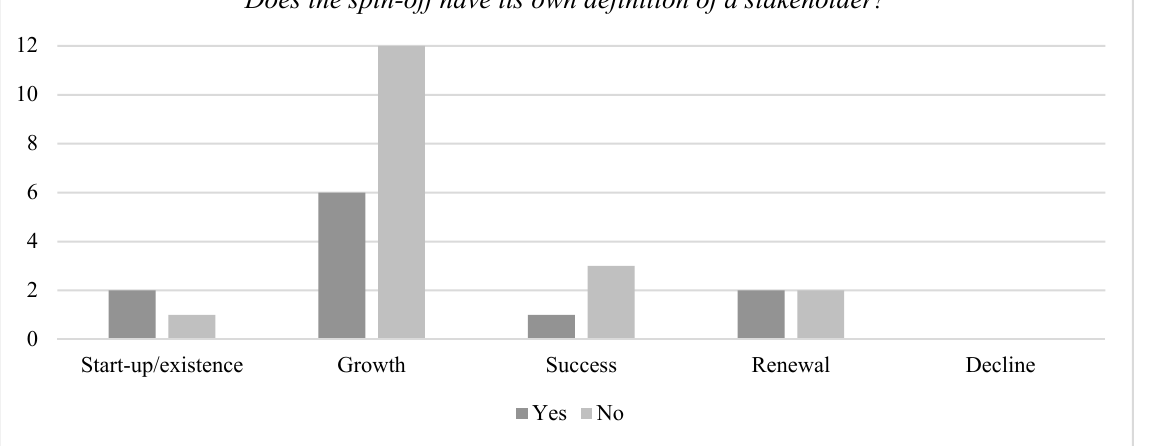
Figure 5. Chart showing whether the spin-off has its own definition about the term stakeholder per OLC stage.